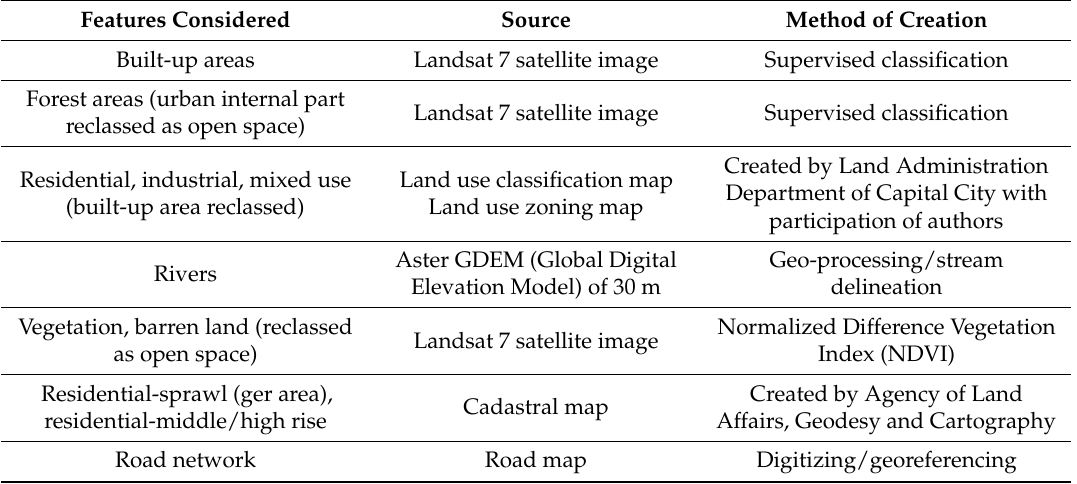
Table 1. Data sources used to create the various information layers for the land-use classes of built-up